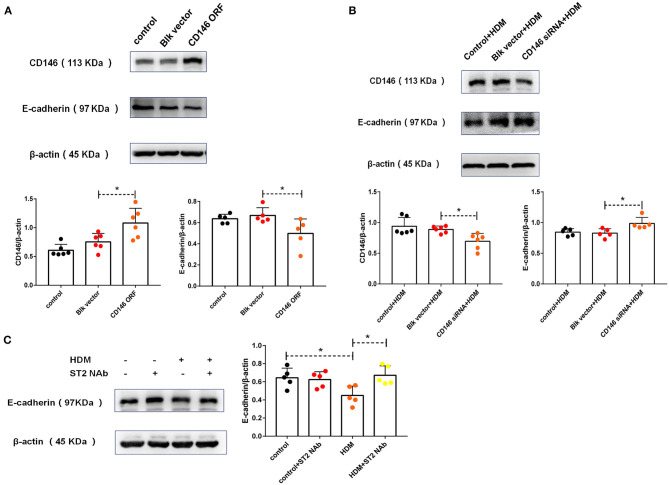
HDM promoted EMT in alveolar epithelial cells via CD146. (A) Western blot analysis of CD146 and E-cadherin expression in MLE-12 cells treated with a CD146 expression plasmid (CD146 open reading frame, CD146 ORF) or blank vehicle (Blk vector). (B) Western blot analysis of CD146 and E-cadherin expression in MLE-12 cells treated with a CD146 siRNA plasmid and HDM extract (100 μg/ml). (C) Western blot analysis of E-cadherin expression in MLE-12 cells treated with HDM extract (100 μg/ml) and an ST2-neutralizing antibody (5 μg/ml). *P < 0.05.